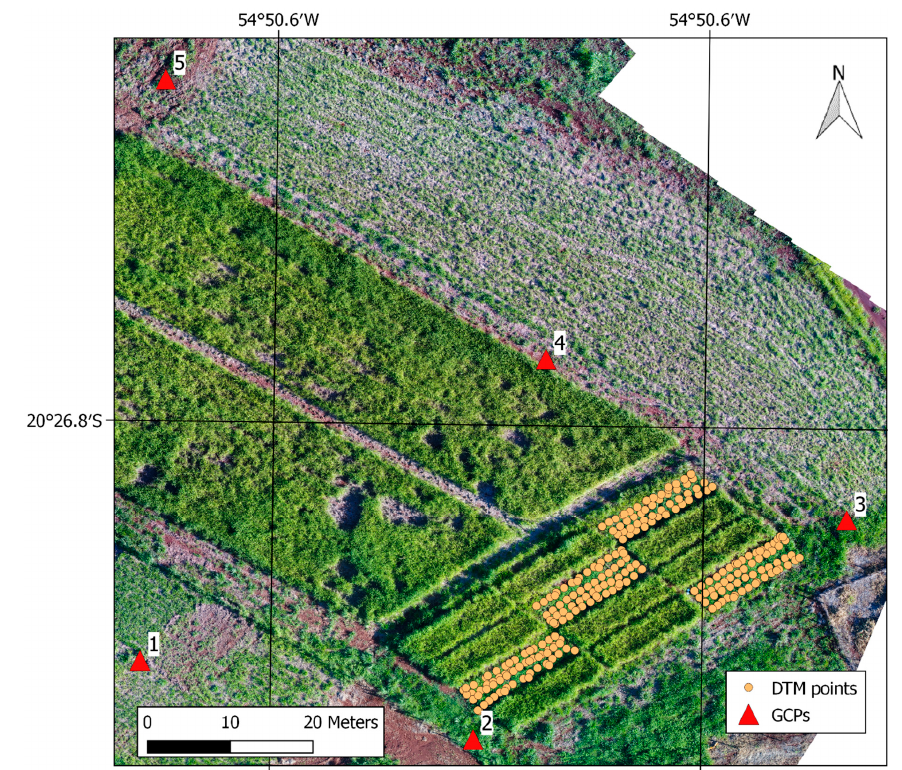
Figure 2. Distribution of digital terrain model (DTM) points and ground control points (GCPs), both collected with real-time kinematics (RTK).